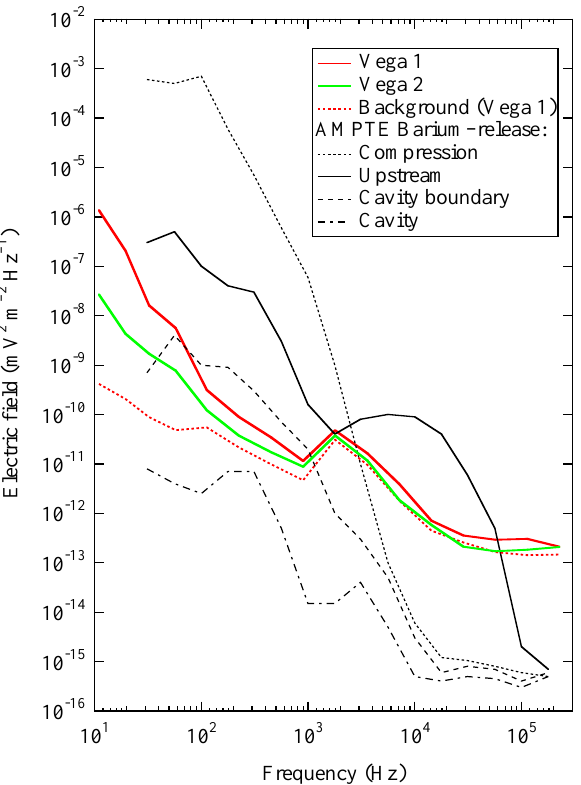
Fig. 12. Plasma wave spectra taken during the IKS gas releases on the Vega spacecraft compared to the AMPTE results reported by Gurnett et al.